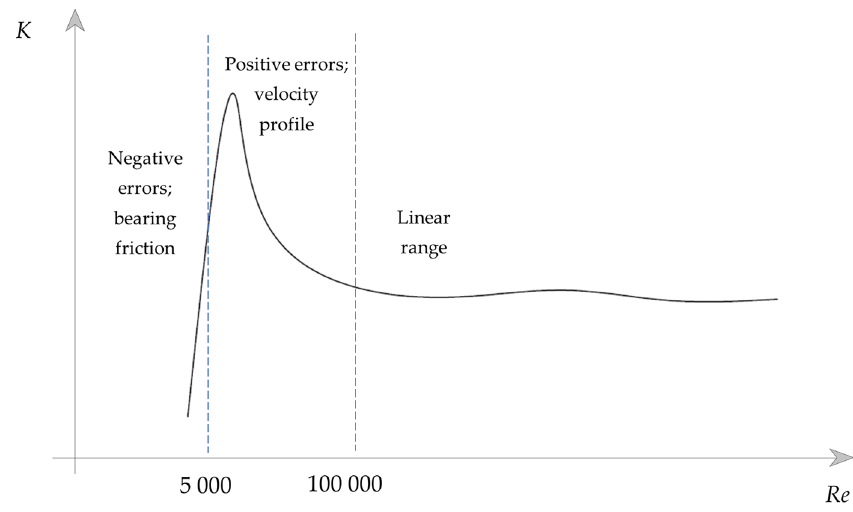
Figure 3. Typical calibration curve for a mechanical oscillator flowmeter in function of the Reynolds number.